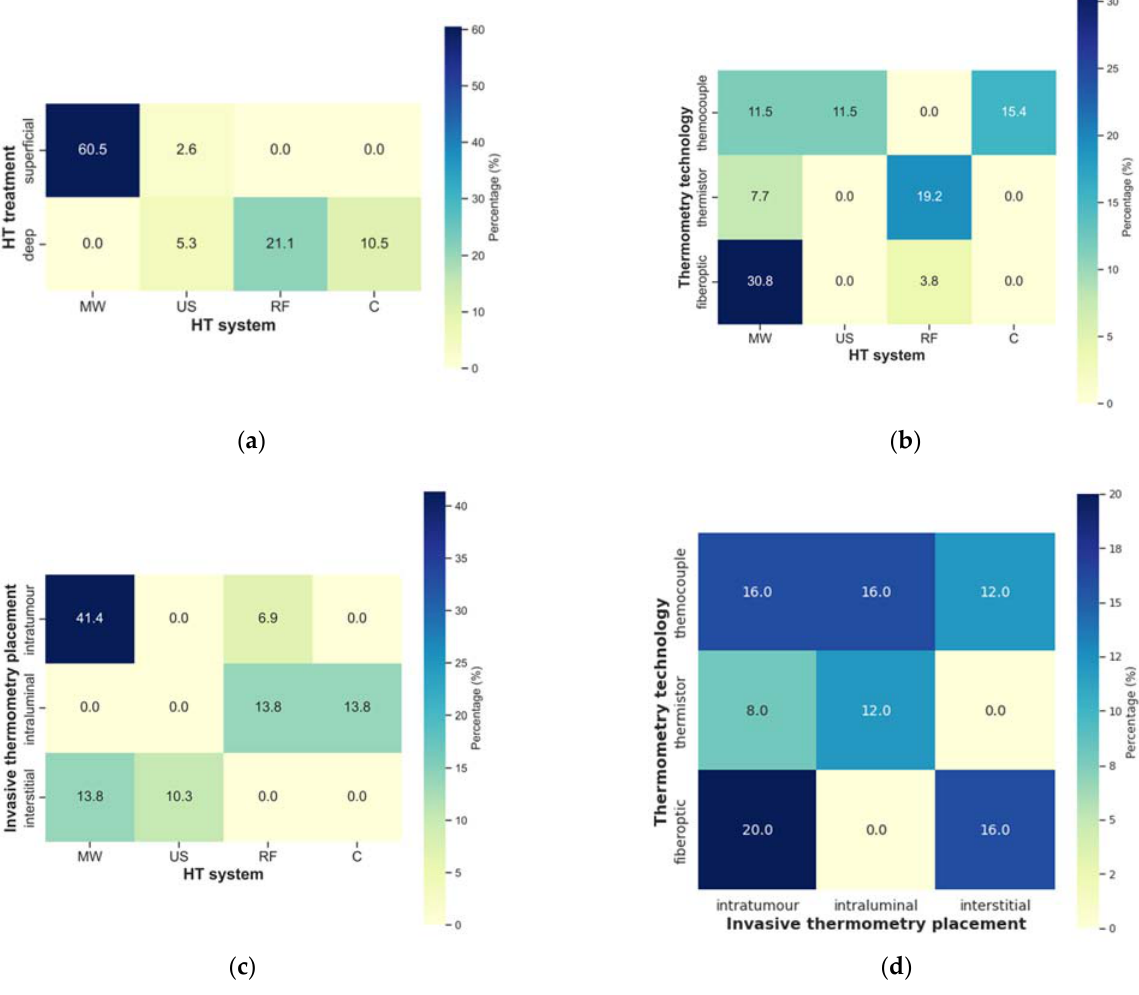
Figure 5. Heatmaps showing the relative frequency of the combination of ( a ) HT treatment vs. HT system, ( b ) thermometry technology vs. HT system, ( c ) invasive thermometry placement vs. HT system, and ( d ) thermometry technology vs. invasive thermometry placement. (MW: microwave, US: ultrasound, RF: radiofrequency and C: capacitive).